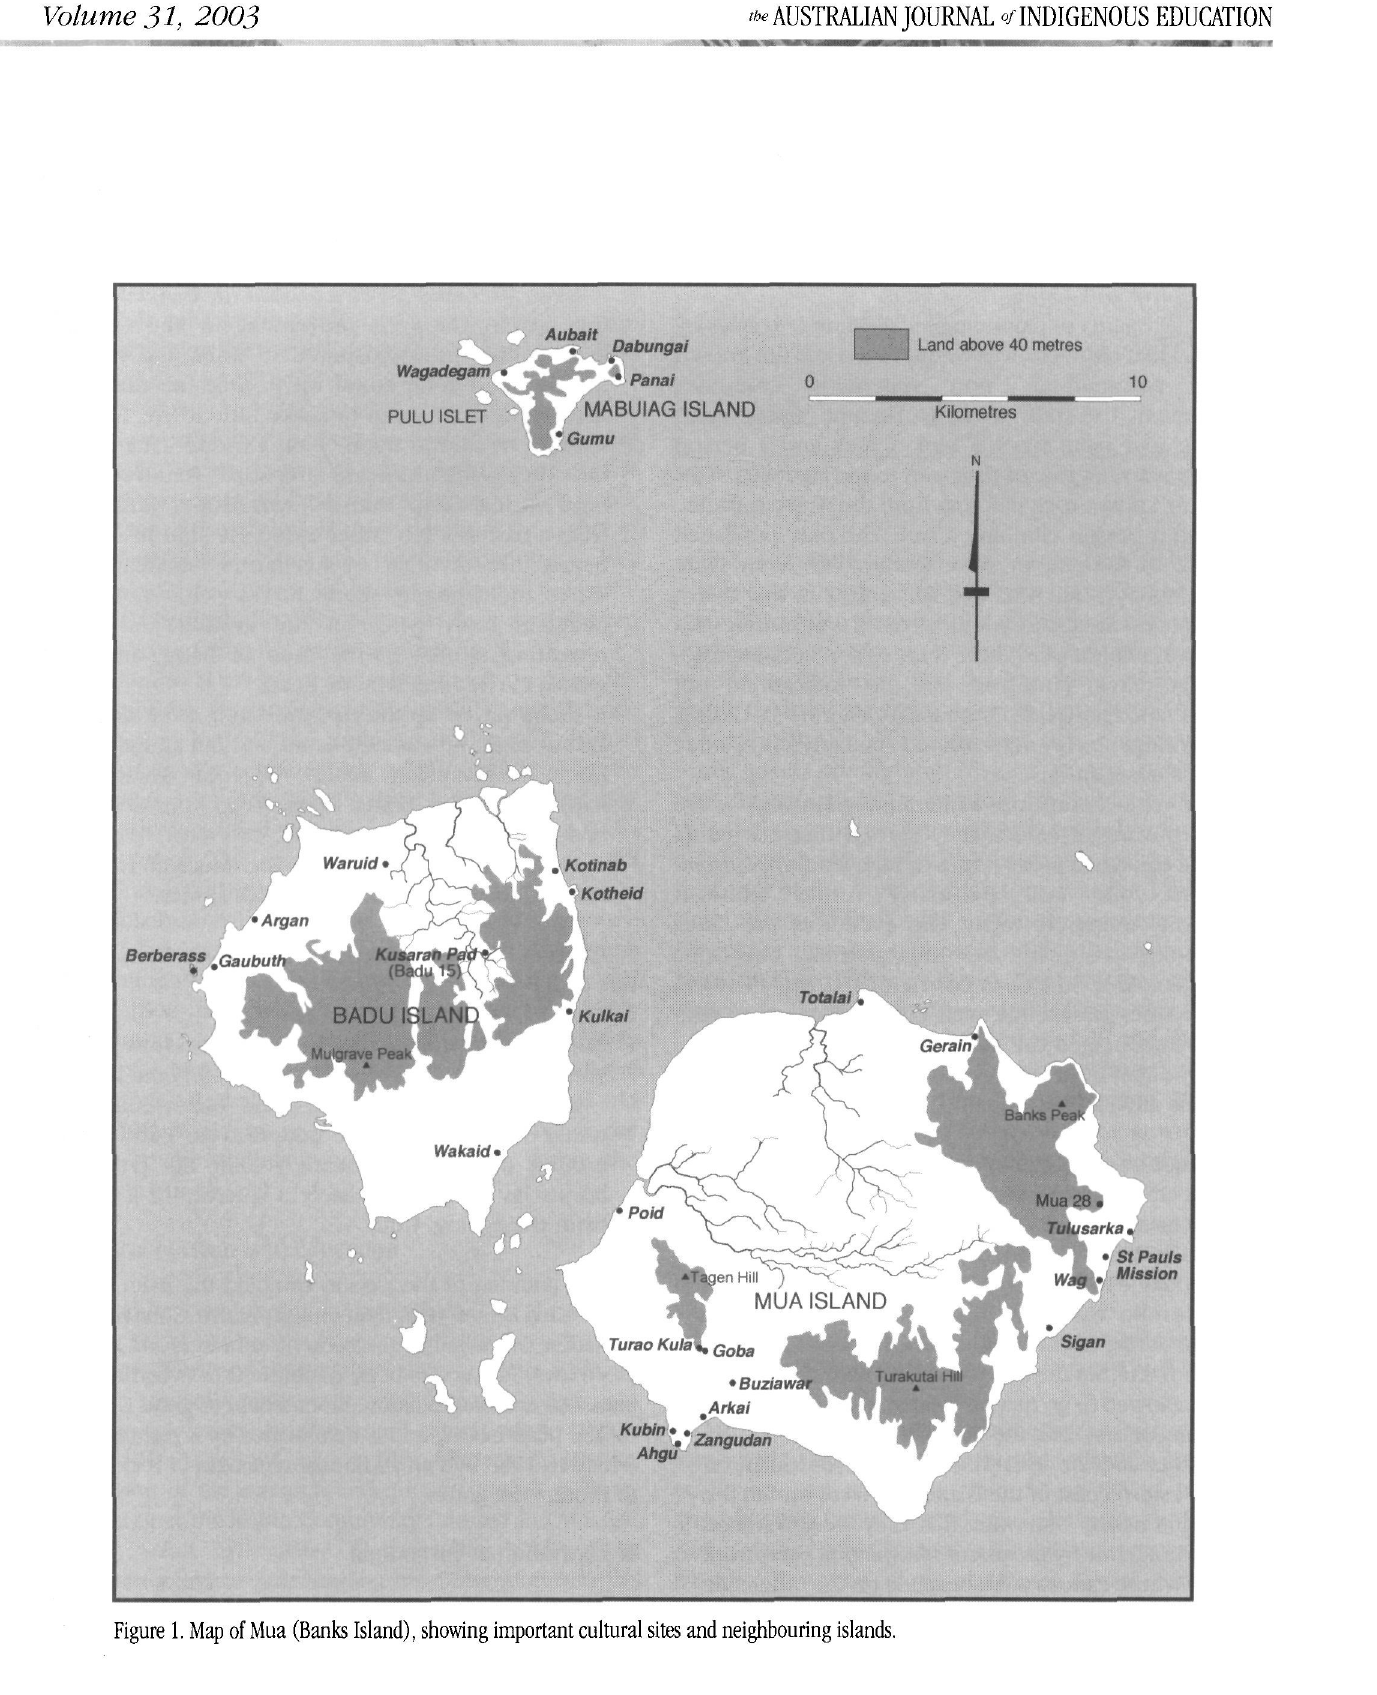
Figure 1. Map of Mua (Banks Island), showing important cultural sites and neighbouring